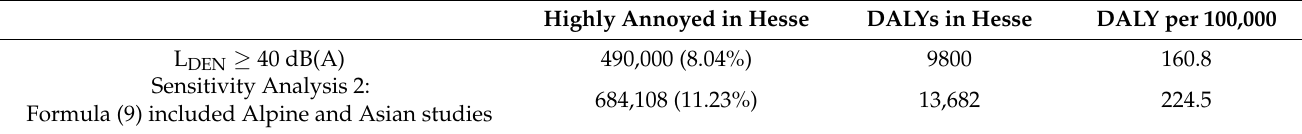
Table 5. Estimated number of residents highly annoyed due to road-traffic noise and respective DALYs in Hesse (all ages). Highly Annoyed in Hesse DALYs in Hesse DALY per 100,000